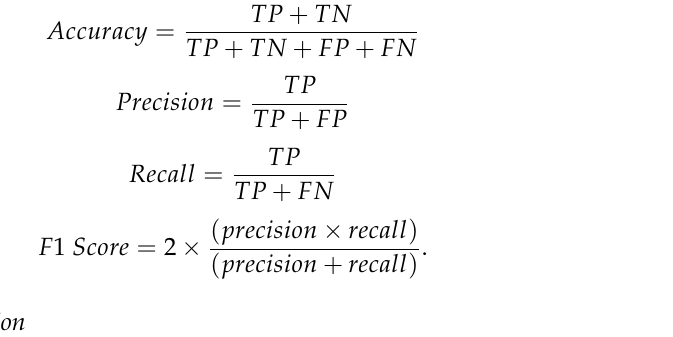
Figure 5. Results obtained of the proposed model during the training and validation phases: ( a ) accuracy and ( b ) loss. Figure 6 shows the confusion matrix obtained in the evaluation of the proposed model. The confusion matrix shows the true positive (TP), true negative (TN), false posi- tive (FP) and false negative (FN) values obtained for each class evaluated [64].